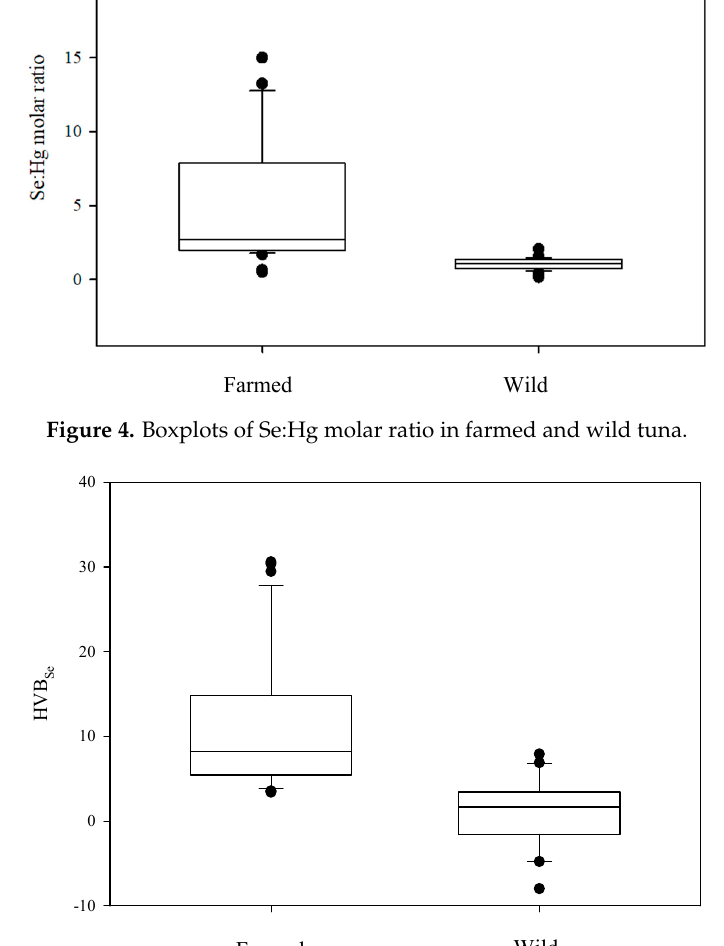
Figure 4. Boxplots of Se:Hg molar ratio in farmed and wild tuna.